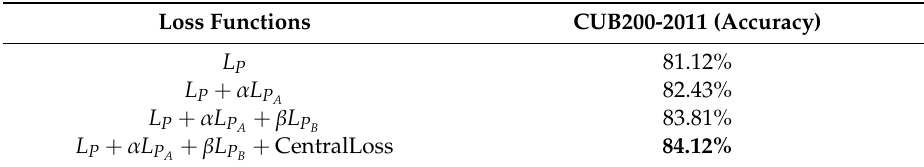
Table 1. Accuracy of di ff erent loss functions.